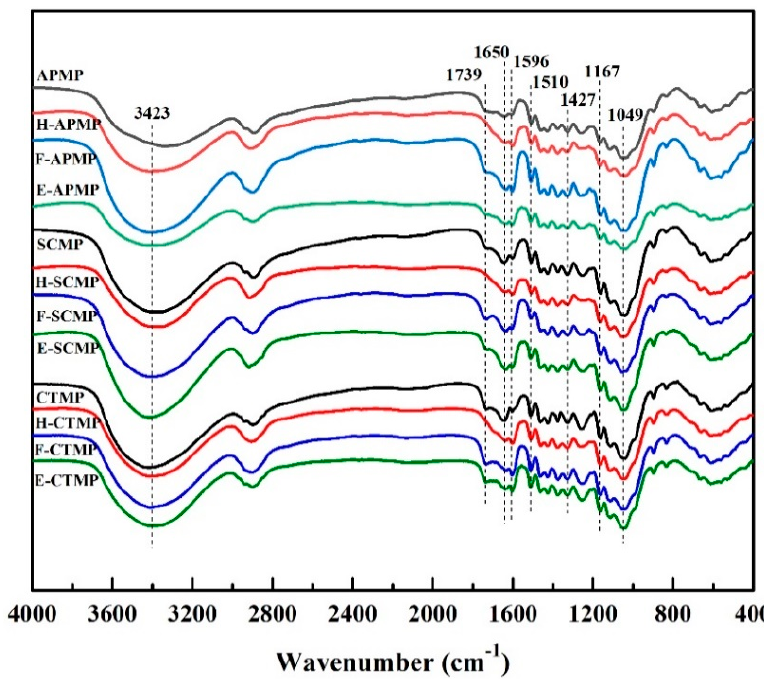
Figure 3. FTIR analysis of the HBMP samples.